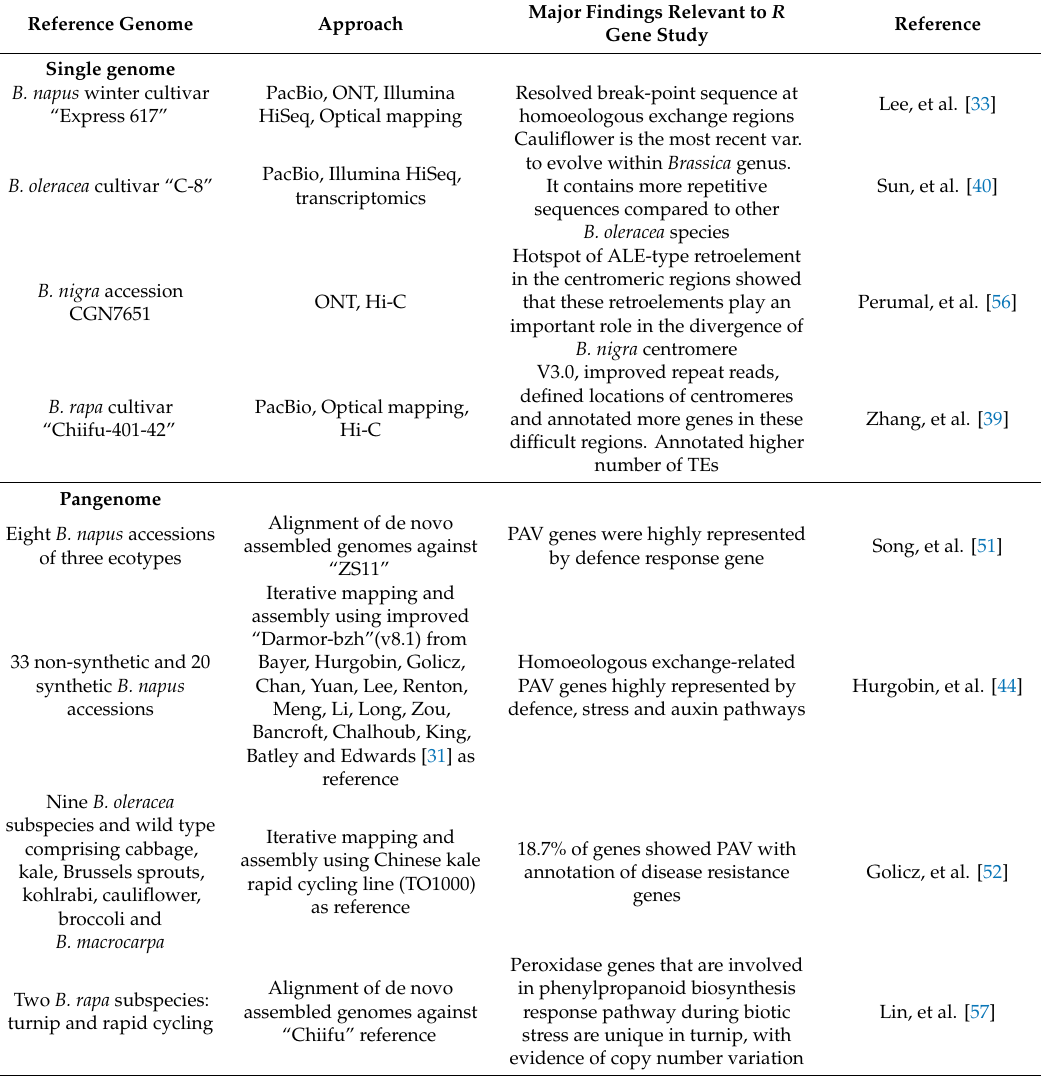
Table 1. Summary of the most recent Brassica reference genomes useful for omics studies in the Brassica